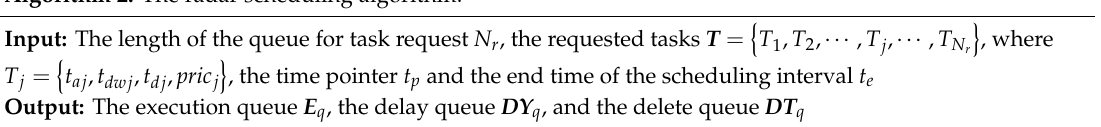
Algorithm 2: The radar scheduling algorithm: